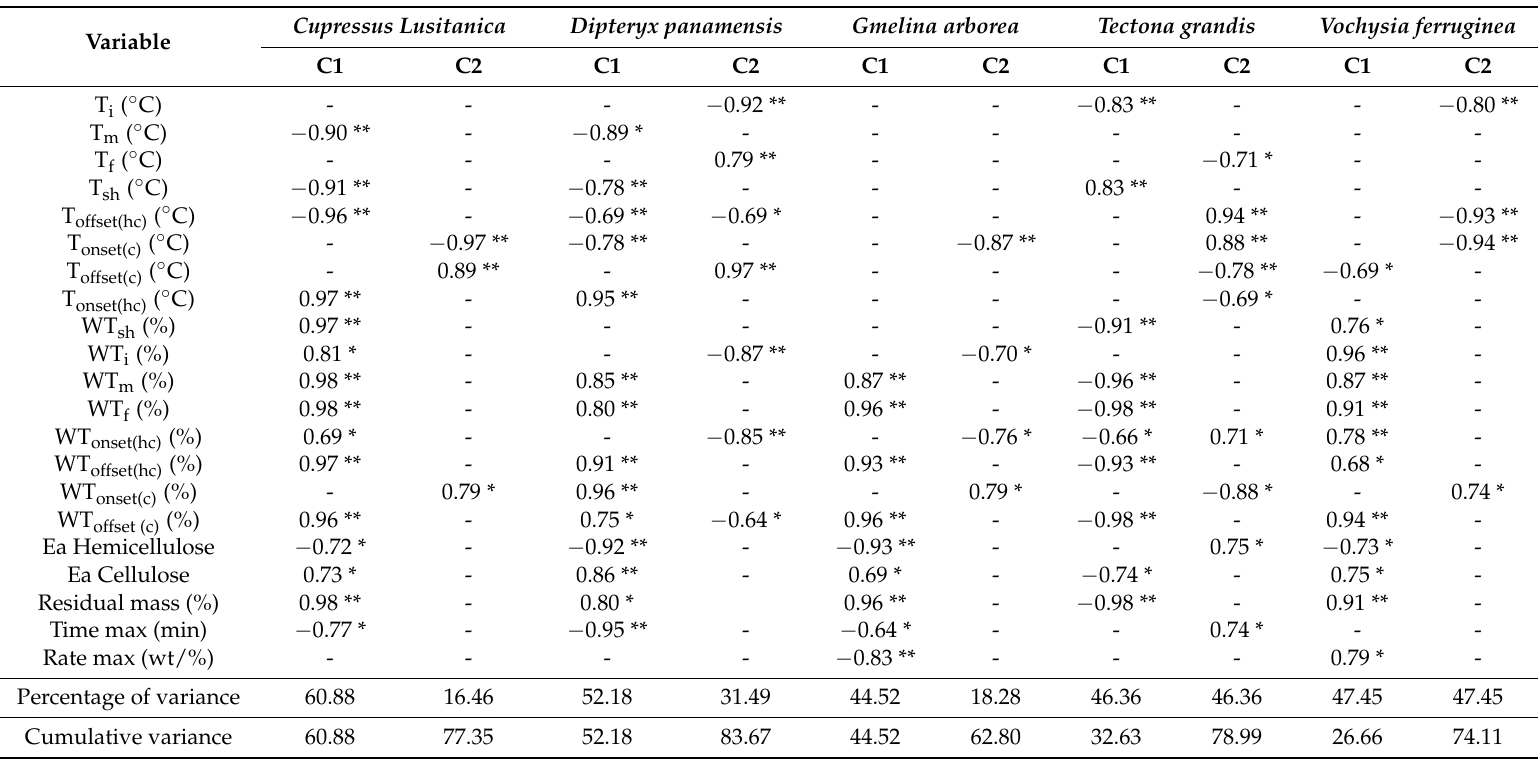
Table 6. Matrix of the multivariate analysis correlations for all variables evaluated of biomass torrefied at different times and temperatures of five fast-growth plantations species in Costa